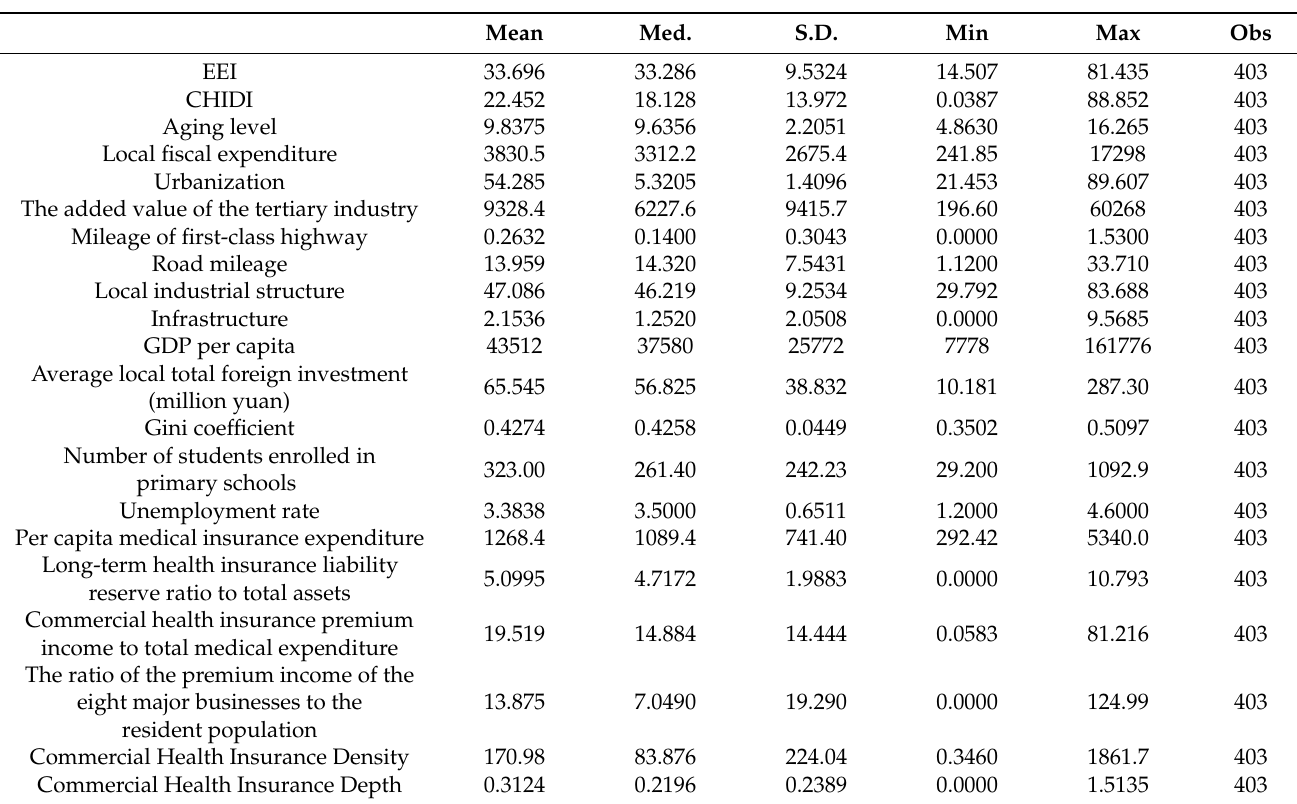
Table 2. Simple descriptive